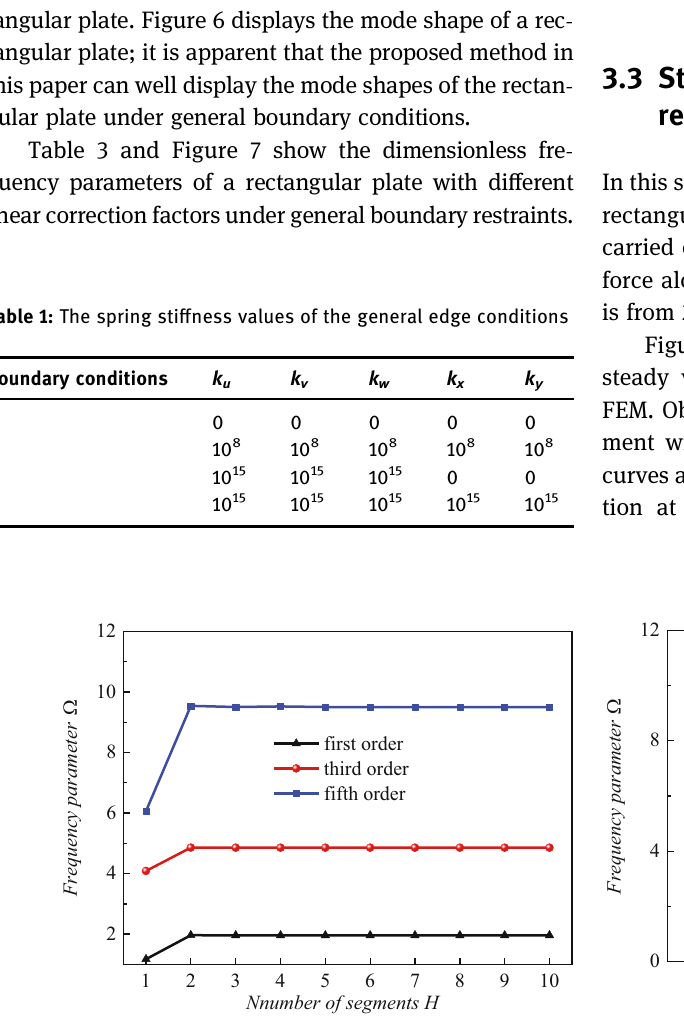
Figure 4: Frequency parameters Ω of rectangular plate with di ff erent convergence